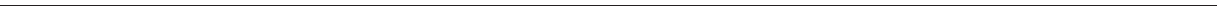
FIGURE 6 | 15 IU eCG treatment group, γ H2AX (green) was strikingly expressed in two daughter nuclei (blue). Scale bar = 20 µ m. (C) Confocal images of RNA FISH for endogenous Aurora B (green) and MAD2L1 (red) mRNA molecules in IVF-derived mouse embryos following administration of different doses of eCG. The embryo nuclei were counterstained with DAPI (blue). Scale bar = 20 µ m. (D) Average FI of Aurora B/MAD2L1/ γ H2AX per IVF-derived mouse embryo in the groups treated with different eCG doses. The continuous FI data were analyzed using Student’s t -test and ANOVA. a,b Different lowercase letters in the columns within each parameter indicate significant differences ( P < 0.05). (E) Percentages of IVF-derived mouse embryos positive for local enrichment of Aurora B and MAD2L1 mRNA signals on chromatin (positivity rates for chromatin-colocalized Aurora B-MAD2L1 foci) in groups of mice administered eCG once at doses ranging from 0 to 15 IU. n shows the total number of embryos. Different letters in the columns depict statistical significance (for a and b, P < 0.05). (F) The relative mRNA expression levels of Aurora B, MAD2L1, and H2AX were analyzed by RT-PCR and normalized to those of β -actin. The differences in these continuous data were analyzed by Student’s t -test and ANOVA. a,b Columns marked with different letters are significantly different from each other ( P < 0.05). (G) Capillary-based immunodetection of protein extracts was performed using a Wes capillary-based device (ProteinSimple) to determine the average levels of Aurora B, MAD2L1, phospho-Aurora B (T232), and γ H2AX. Every experiment was performed in triplicate. a,b Different superscripts above the error bars show significant differences ( P <